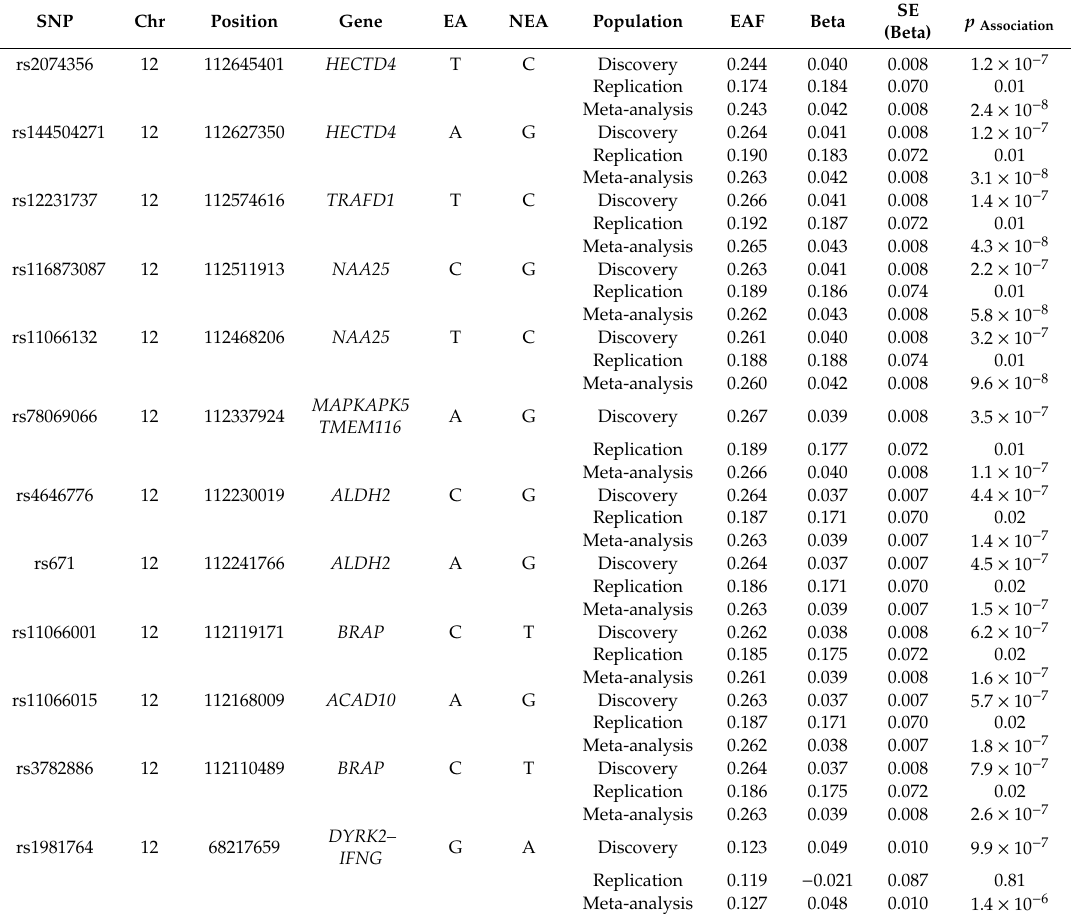
Table 2. Variants associated with habitual black tea